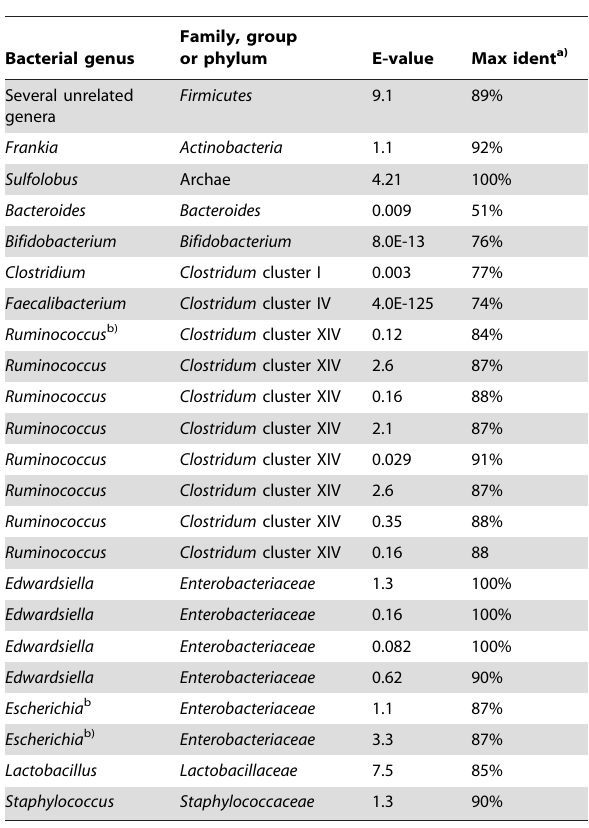
Table 3. Genera of bacterial GUD